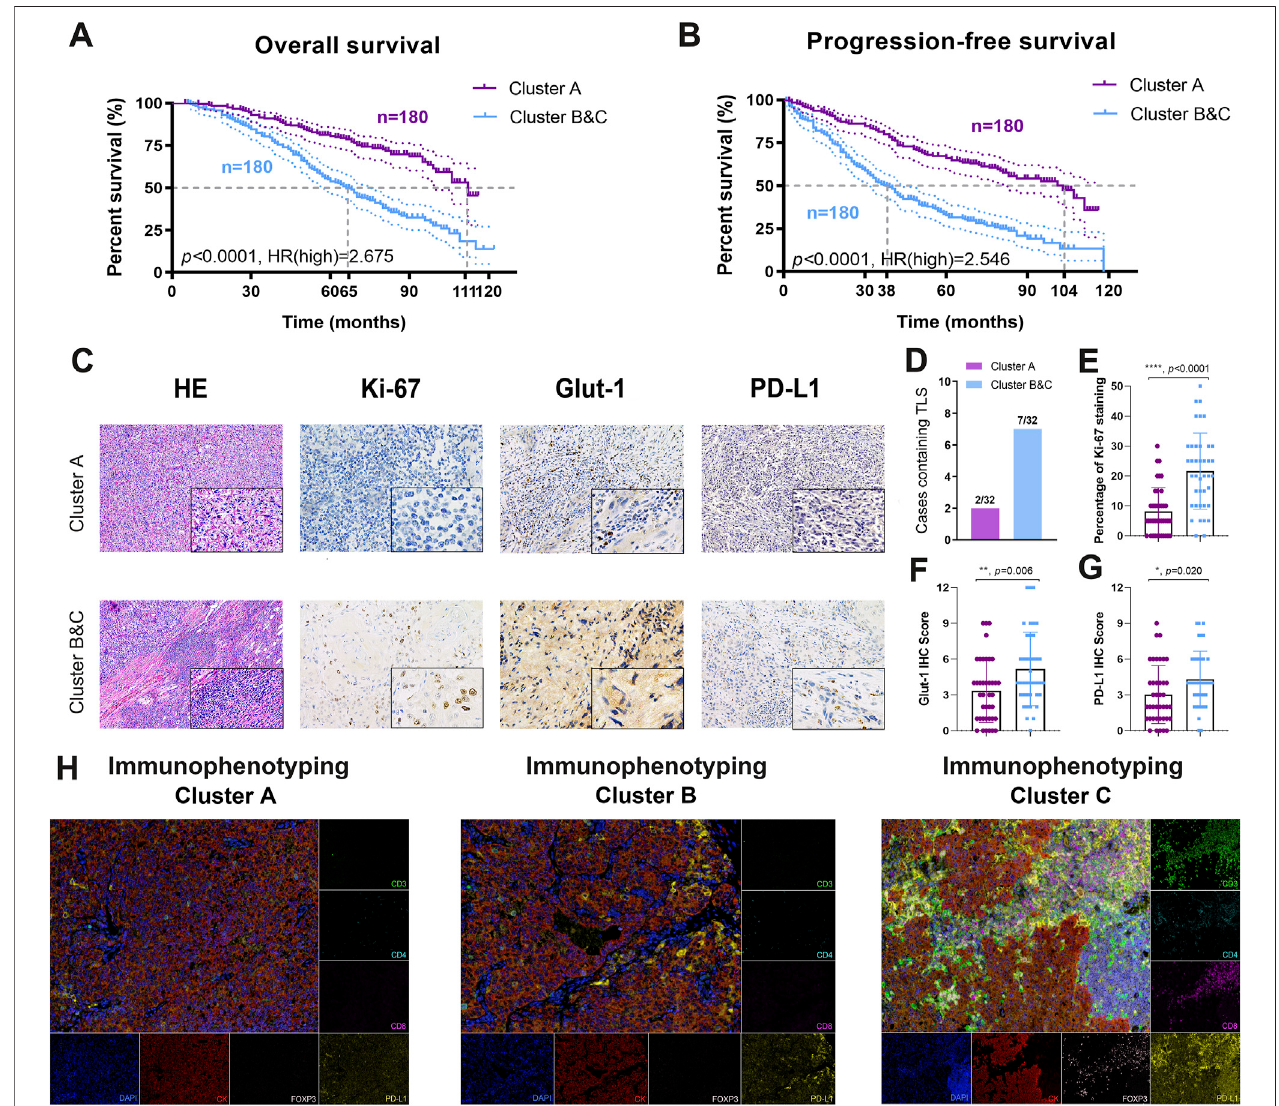
FIGURE 8 | Prognostic implications and TME characterizations of immunophenotyping clusters in a real-world validation cohort. (A, B) A total of 360 ccRCC patients with long-term follow-up information from the FUSCC cohort were enrolled to identify the prognostic value of immunophenotyping clusters in the validation cohort. (C – G) Characteristics of the tumor microenvironment between immunophenotyping clusters were explored using (H, E) and immunohistochemical staining analysis in different clusters. (H) Opal multi-label IHC staining was used to identify the abundance of CD 8+ T cells, CD 4+ FOXP 3+ Treg cells, and CD 3+ CD 4+ CD 8+ TCRn immune cell in fi ltration and PD-L1 expression in